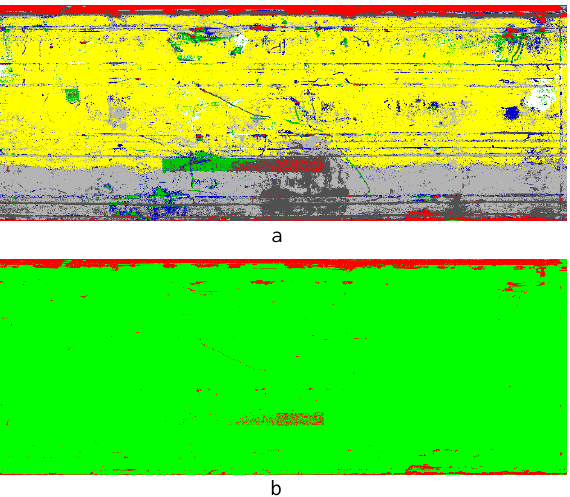
Figure 4. Results for the highest classification performance w. r. t. corrosion detection for seven and two classes. a) Shows the seven class result for the HSI, Range Intensity and Range Derivative image with the following pixel colors per class: yellow – unaffected, red – corrosion, blue – red lacquer, green – white lacquer, light gray – light dirt, dark gray – dark dirt, white – reflection. b) shows the two class result for the HIS, Range Intensity and Range Derivative image with green pixels representing the unaffected class, and red pixels the corrosion